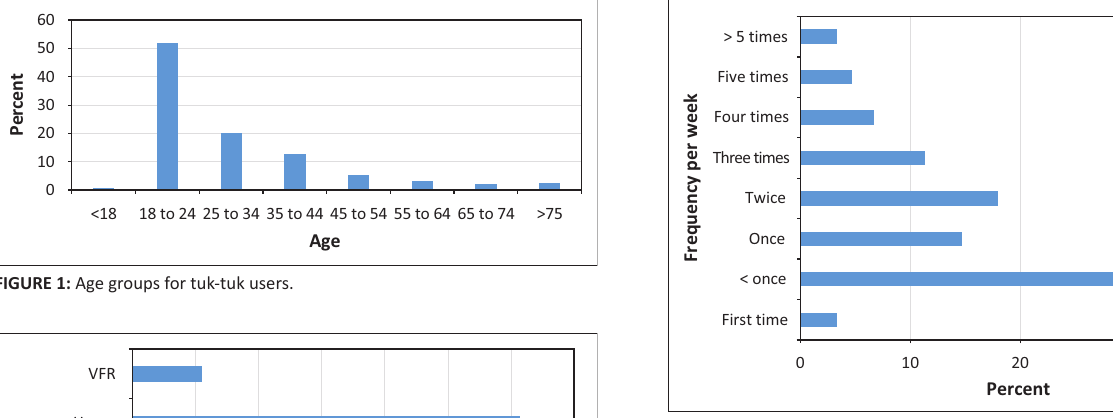
FIGURE 3: Trip frequency.